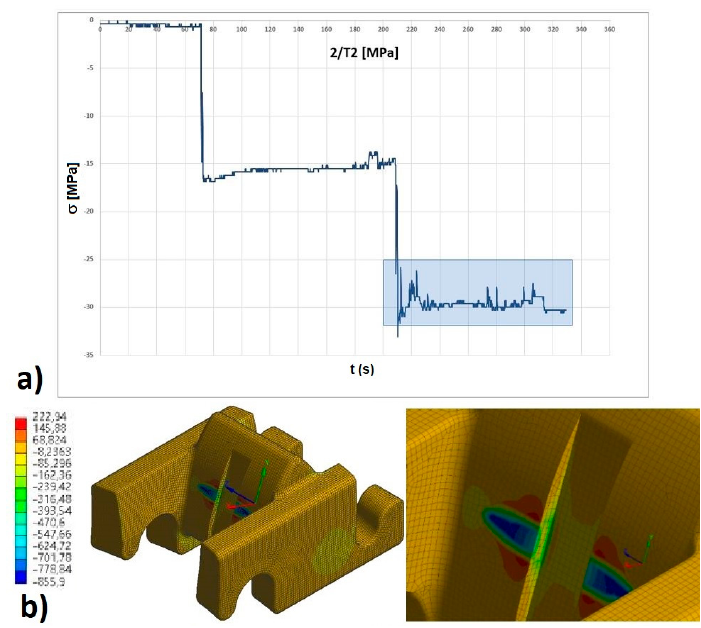
Figure 18. Values of main stresses in the contact place of the track wheel with the toothed segment with two glued strain gauges: ( a ) result of conducting strain gauge tests, ( b ) result of the FEM sim- ulation.